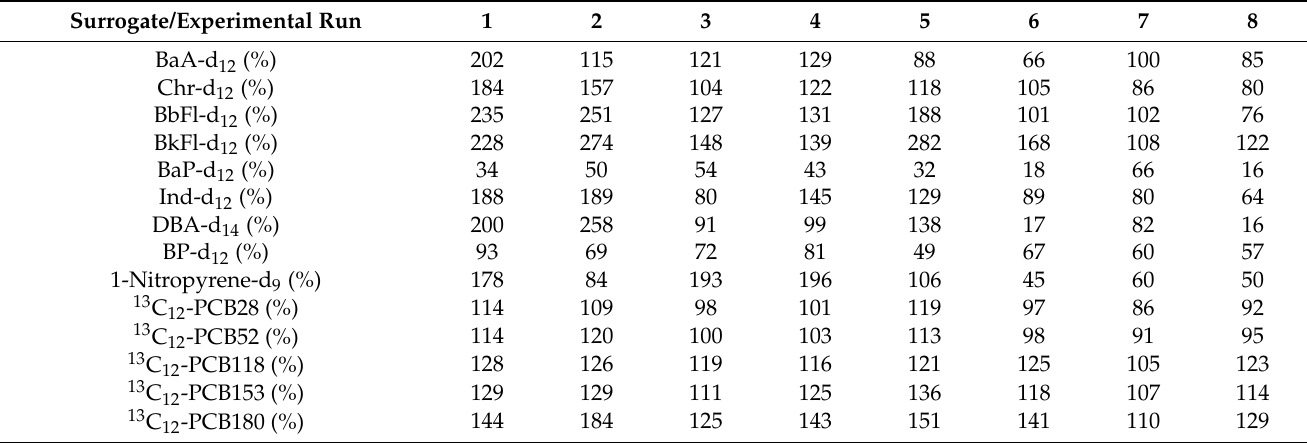
Table 3. Experimental responses (extraction recovery percentages) for PAH, nitro-PAH and PCB surrogates for each experimental